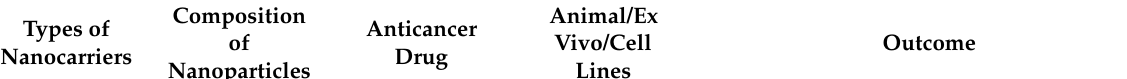
Table 1. Anti-cancer drug-loaded mucoadhesive nanocarriers for the treatment of oral